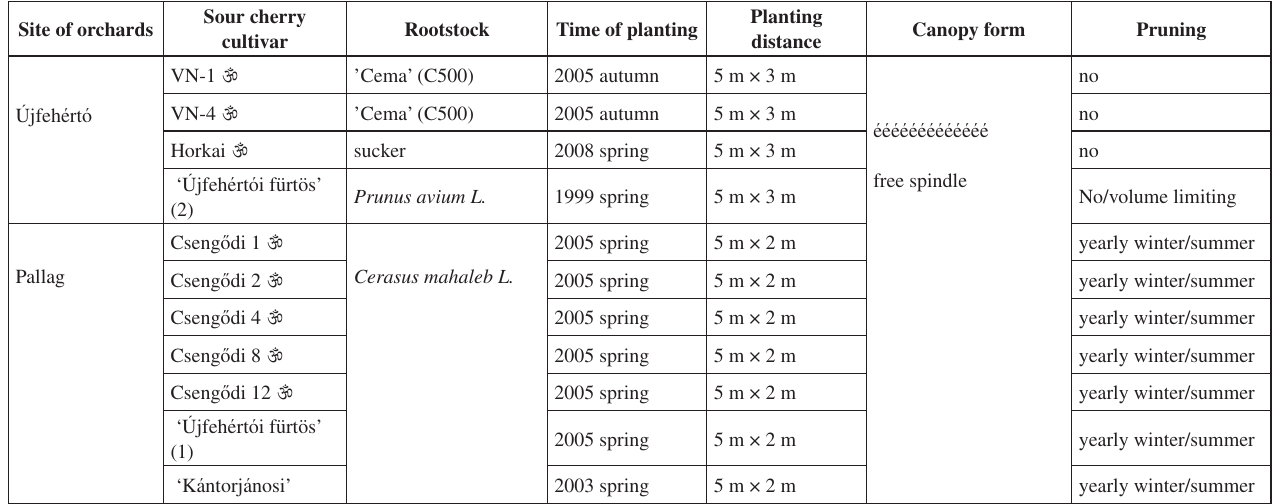
Table 1: Parameters of the investigated cultivars and orchards (Pallag and Újfehértó,